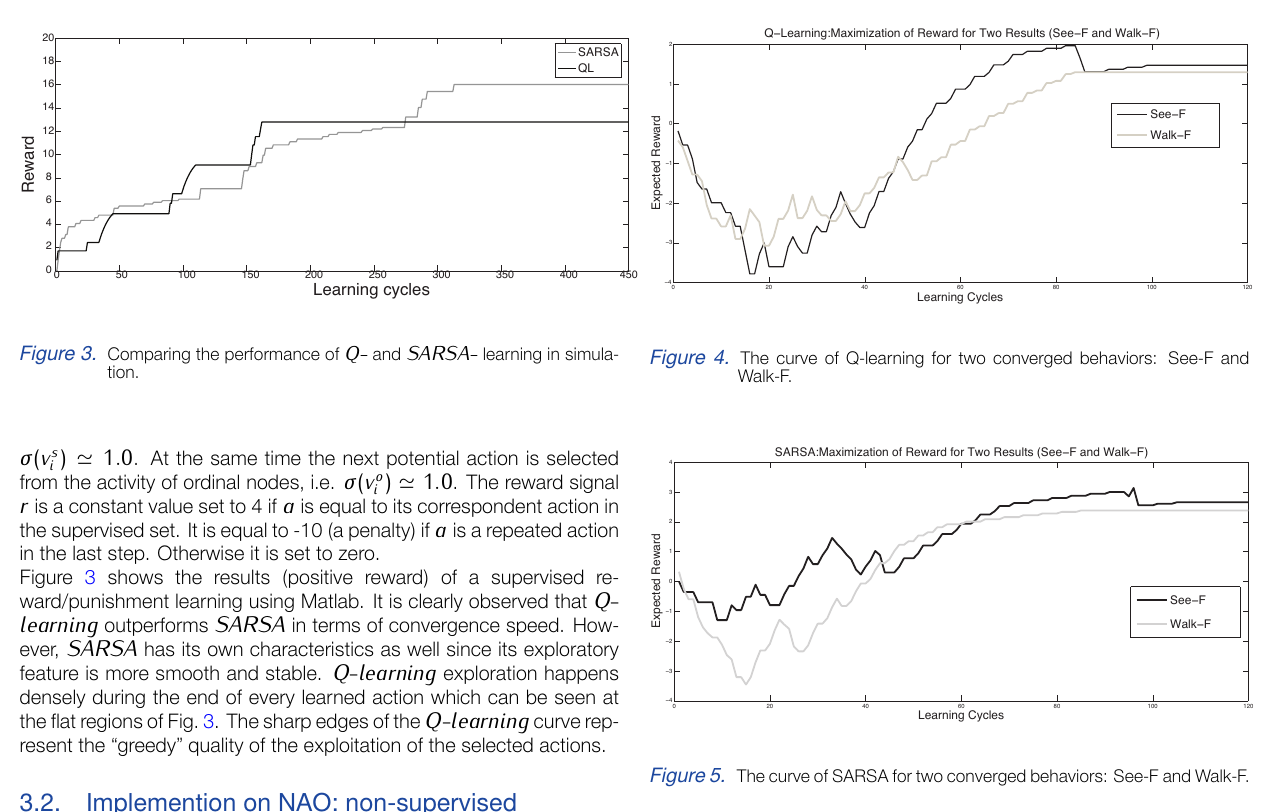
ε − greedy policy both do not work well in the beginning, the robot needs to explore to get penalties in order to know which action